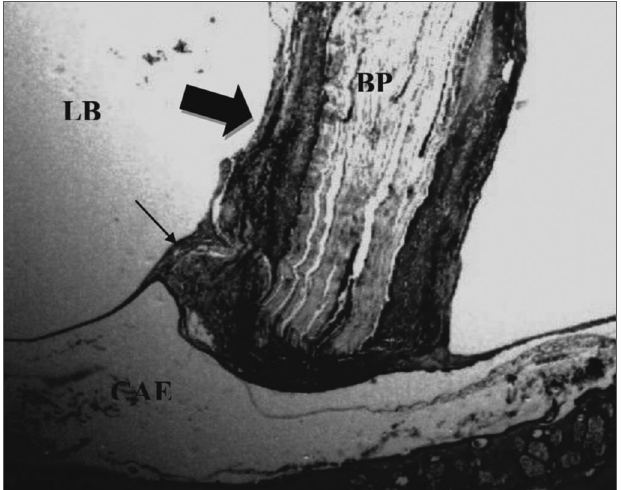
Figure 2. Signs of biomaterial absorption - Microphotography of the membrane’s structural disorganization; sugar cane biopolymer; and its partial absorption, seen in the tympanic bulla at 8 weeks; BP= sugar cane biopolymer; thick arrow = inflammatory exudate. HE (40x